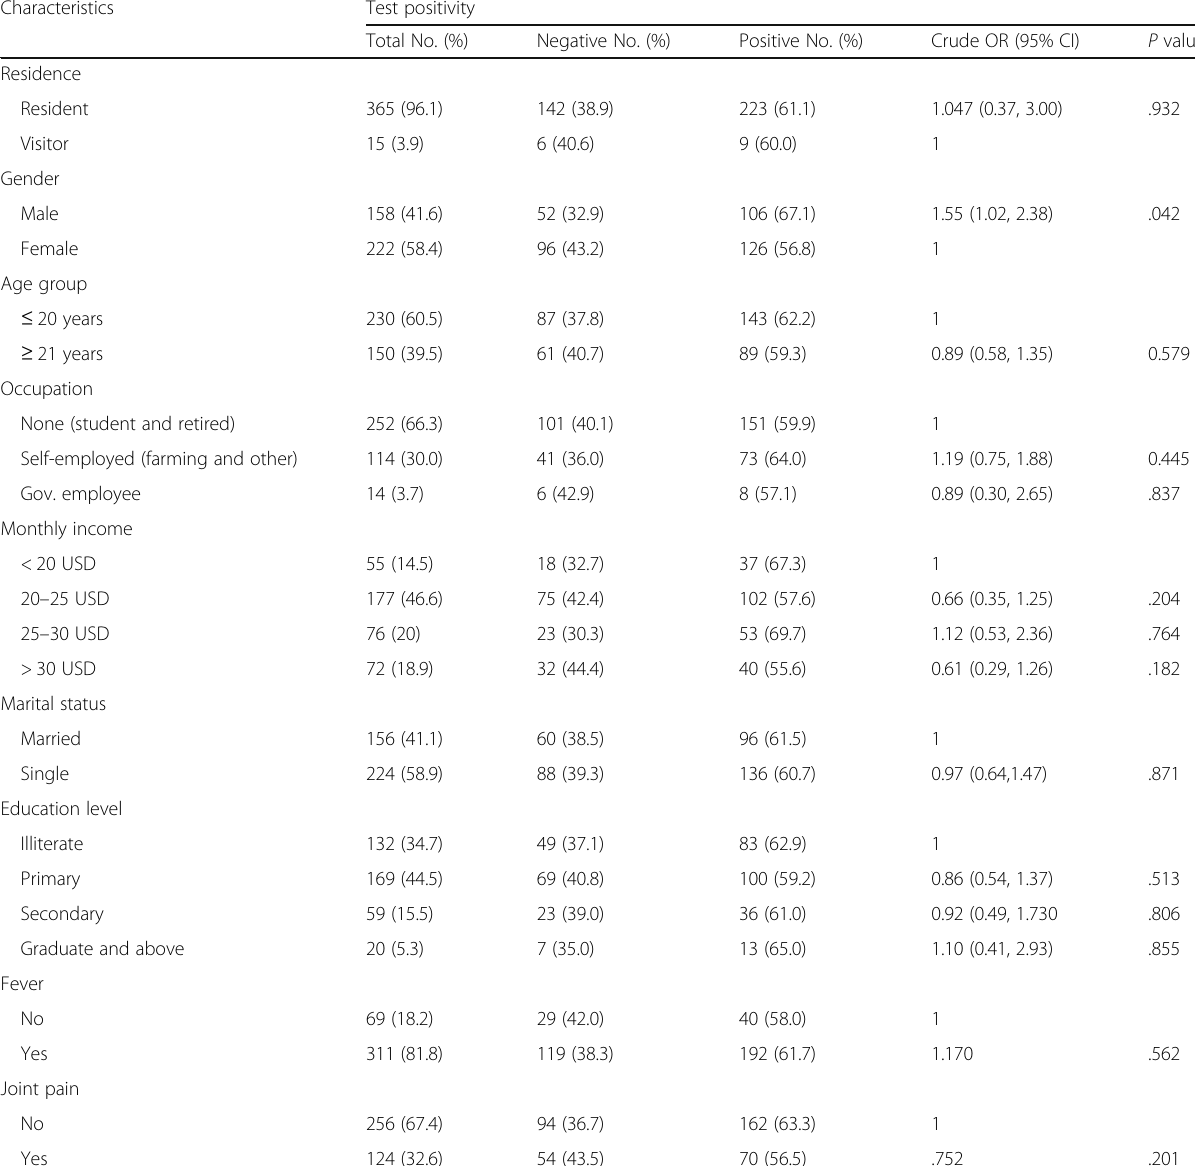
Table 2 Factors associated with test positivity for malaria